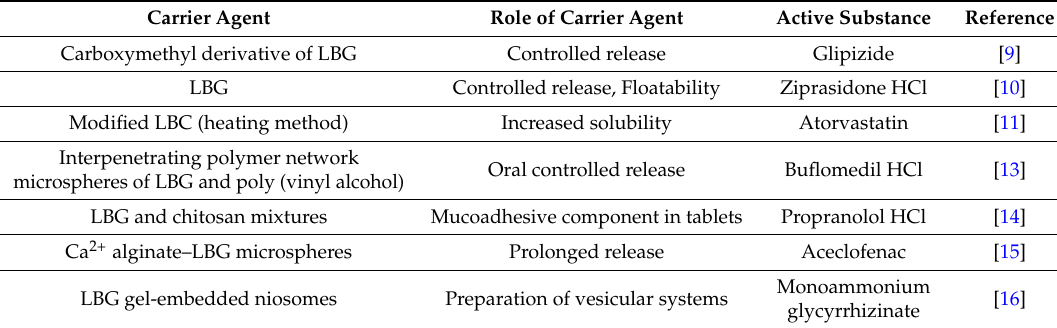
Table 3. Representative applications of locust bean gum (LBG) as drug carrier in drug formulations. Carrier